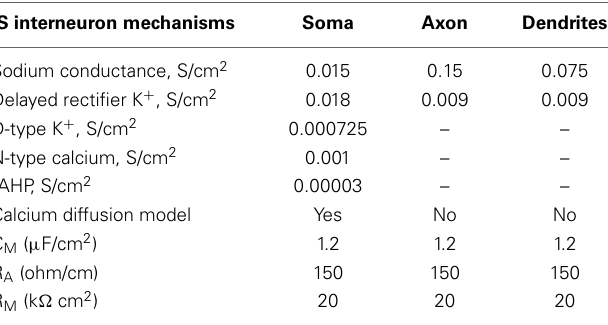
Table 4 | Active and passive ionic properties of IS interneuron model.